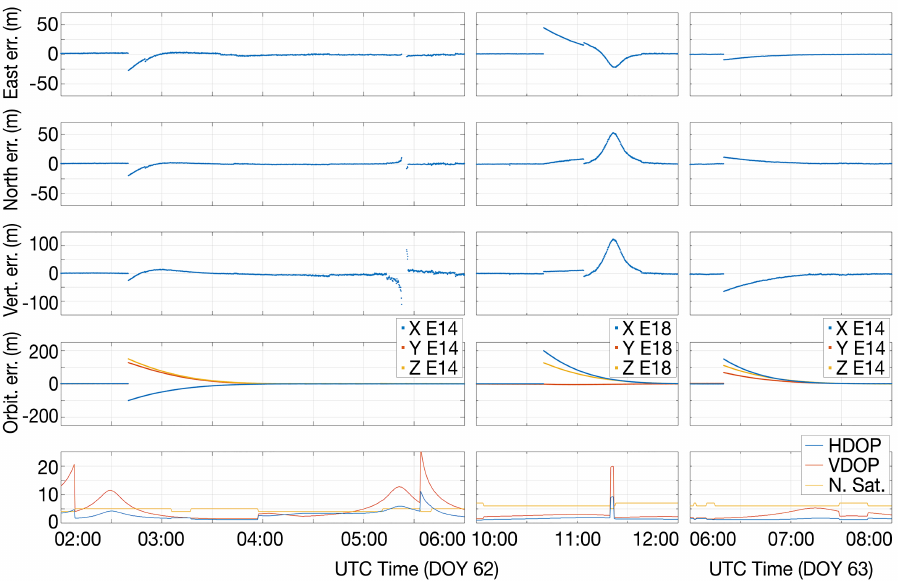
Figure 18. Analysis of the causes of the largest position errors. The time series of errors on the east, north, and vertical coordinates are represented in the first, second, and third row, respectively. The fourth row shows the orbital errors of the E14 (first and third columns) and E18 (second column) satellites. Finally, the fifth row shows the time series of HDOP (blue), VDOP (red), and the number of visible satellites (yellow). Each column shows the data related to the same time